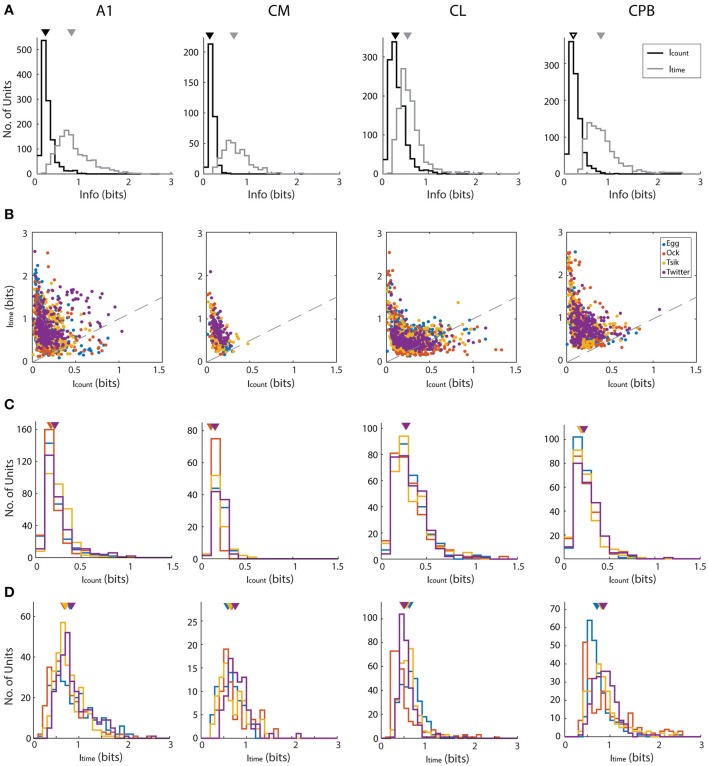
Mutual information about pitch in spike-count and first spike latency for different calls in different auditory cortex neuronal populations. (A) Distributions of information, calculated using conditioned entropy estimation, across all calls, in spike-count (black) and in first spike-latency (gray) of different auditory cortical populations (labels above each column of figures). In each panel the triangle indicates the mean of the distributions. Note that in all fields, first spike-latency carries much more information than does spike-count. (B) Scatter plots of information in spike-count vs. that in first spike-latency of individual units in different cortical fields. Different colors indicate different calls (see legend in row B, last panel) and the dashed gray line indicates the line of unity. For all calls in all fields, first spike-latency carries much more information than does spike-count. (C,D) Distribution of information content of spike-count (C) or of first spike-latency (D) for each of the four calls, in the four cortical fields. Triangles indicate the mean of each distribution and different colors indicate different calls (see legend in row B, last panel).